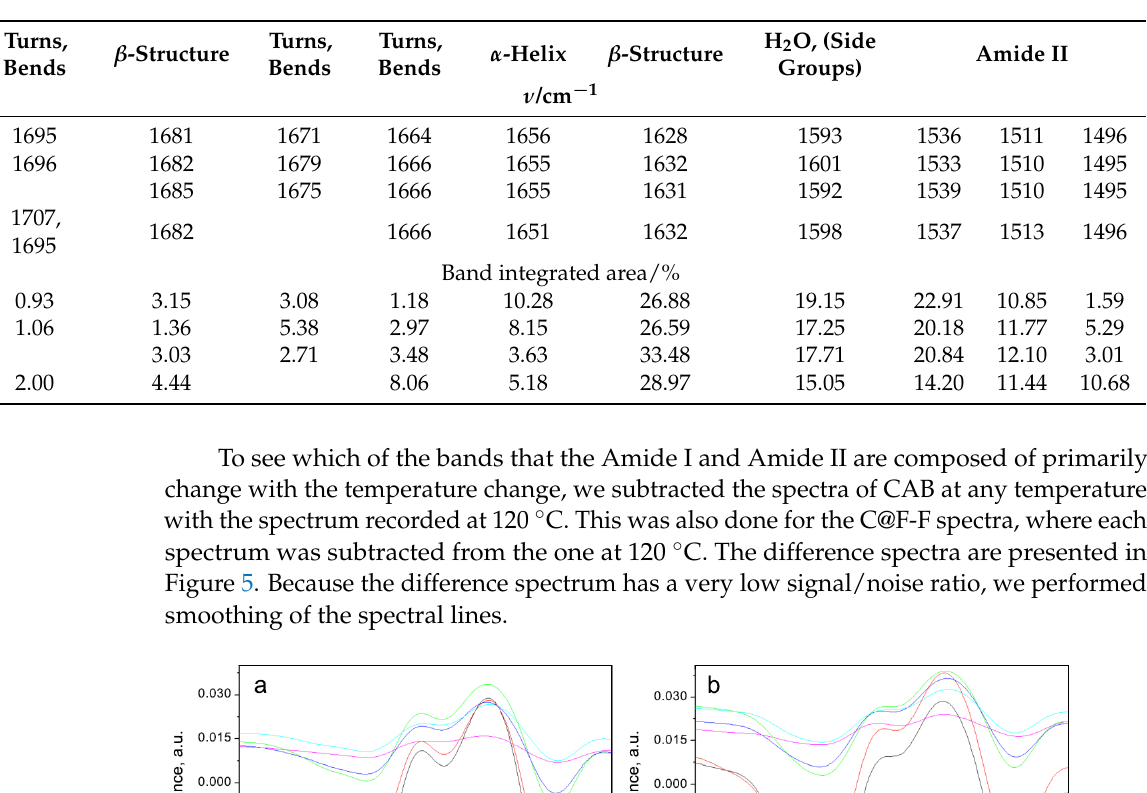
Table 2. Wavenumber maxima in cm − 1 and band areas in percentage from the deconvoluted bands of Amide I and Amide II.